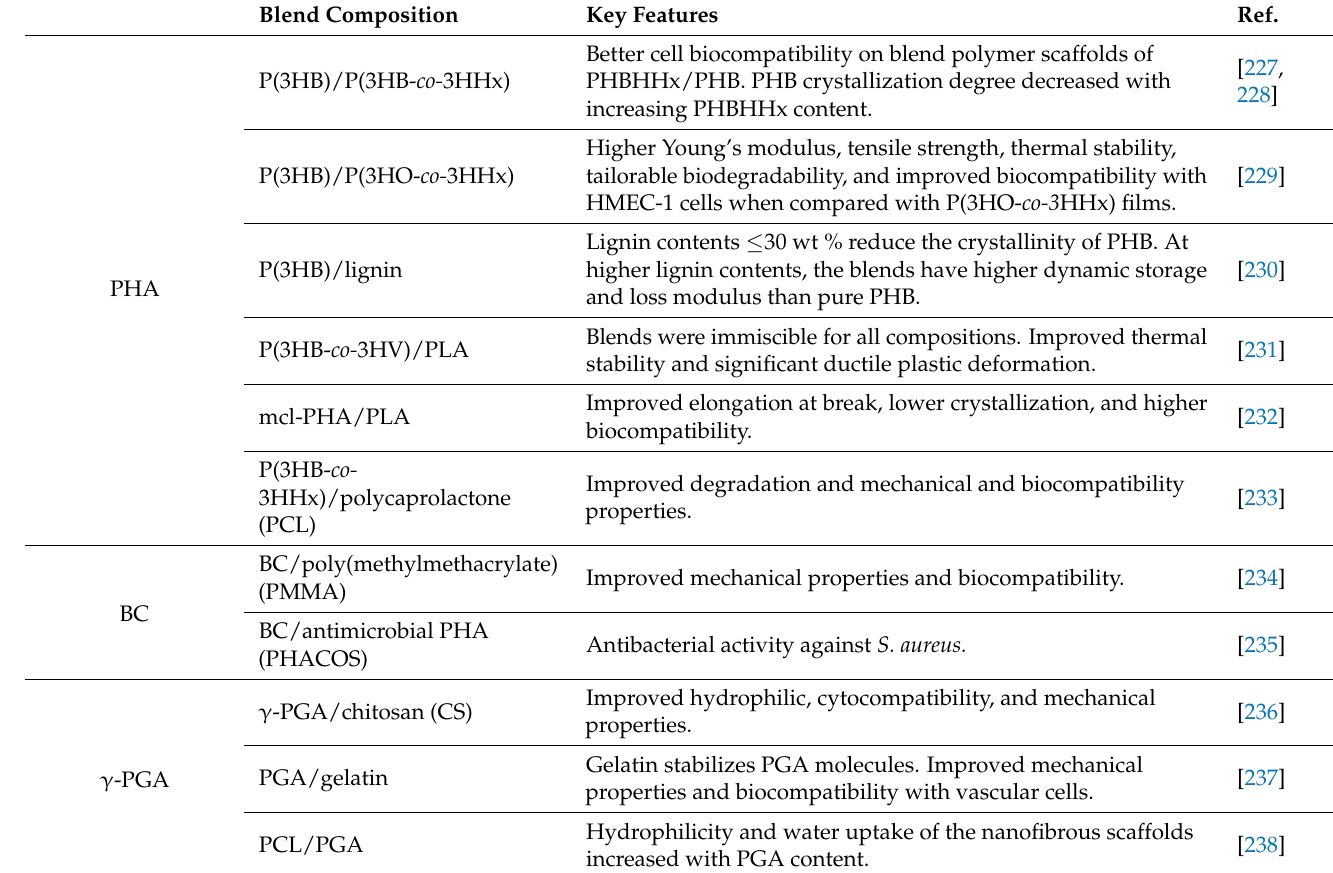
Table 5. Examples of chemical modifications of bacterial polymers. Blend